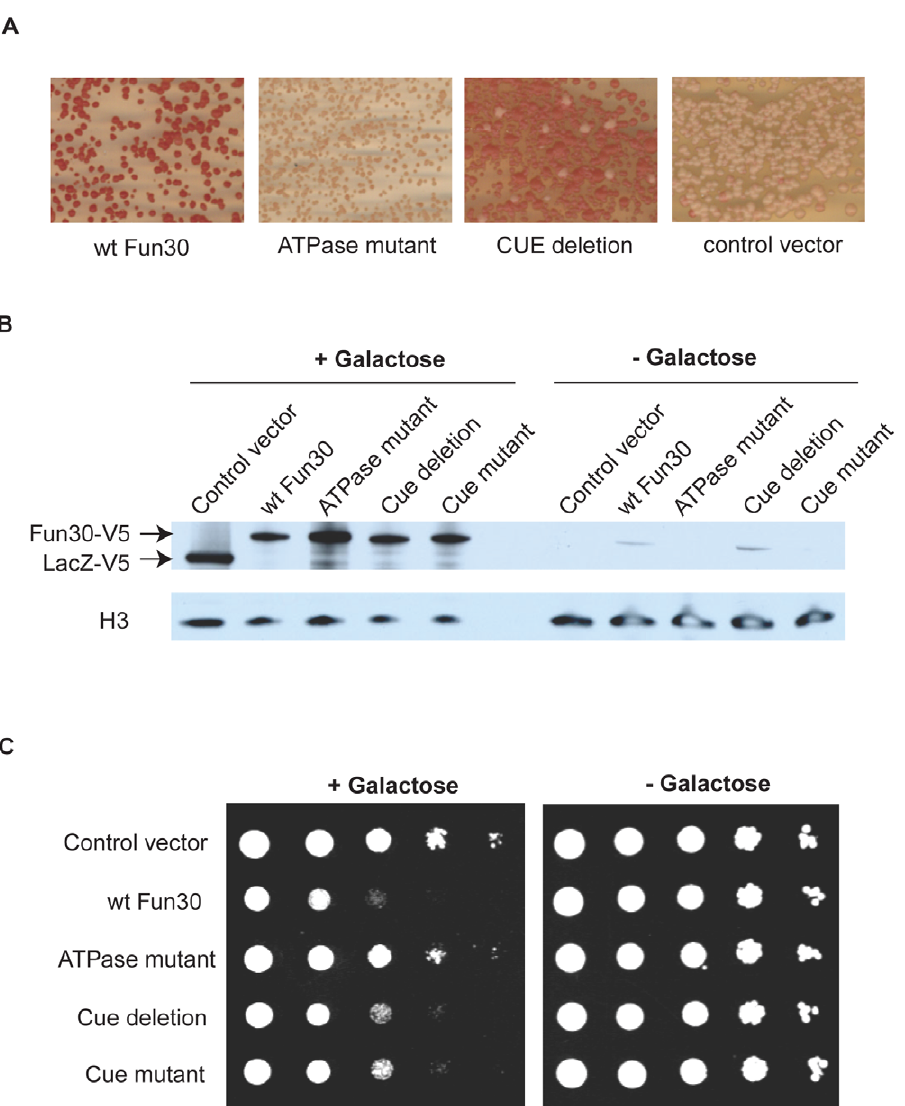
Figure 9. Role of ATPase function and putative CUE-motif in Fun30 activity. A. Silencing of the ADE2 reporter in YLS586; fun30 D is restored by expressing wildtype Fun30 in trans , but not by a Fun30 ATPase mutant or by a control vector expressing LacZ. Expression of Fun30 with the putative CUE motif deleted does not restore silencing as monitored by red pigment formation. Expression was in galactose at 30 u C, driven by the galactose-inducible promoter of GAL1 . B. Immunoblot analysis of the Fun30 protein in trans -expression with anti-V5 antibody. An immunoblot for histone H3 served as protein loading control. V5-tagged Fun30 and indicated mutants thereof were expressed in trans in a galactose- or glucose dependent manner in Fun30 containing strain JRY7385 from multicopy plasmids, the control vector expresses V5-tagged beta-galactosidase. C. Cells from (B) were serially diluted 10-fold, spotted on media with galactose or with glucose and grown for 3 days at 30 u C.